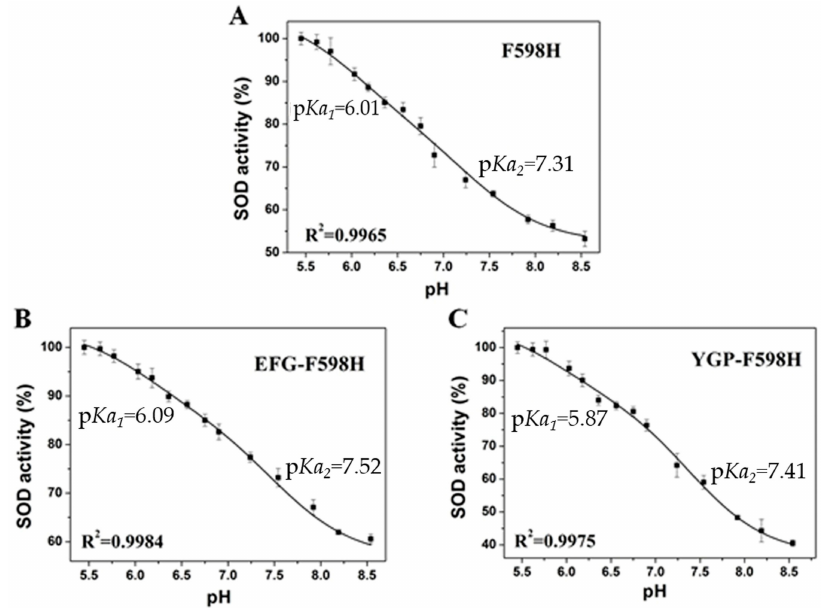
Figure 7. The effect of pH changes on the rate constants for the enzyme reaction of F598H ( A ), EFG-F598H ( B ), and YGP-F598H ( C